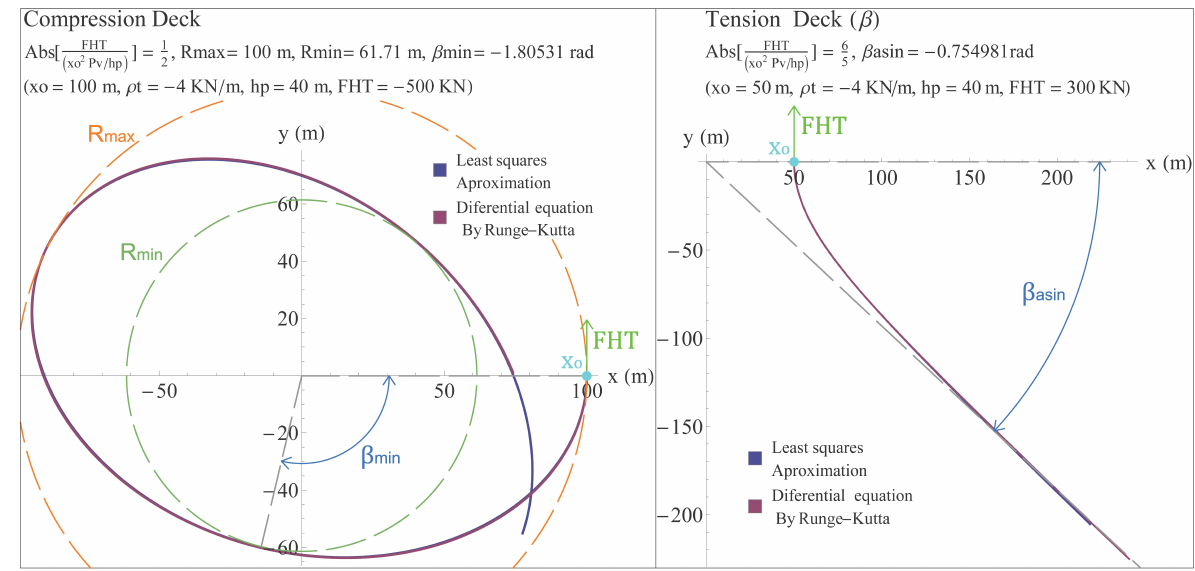
Figure 4: Least squares approximation test.